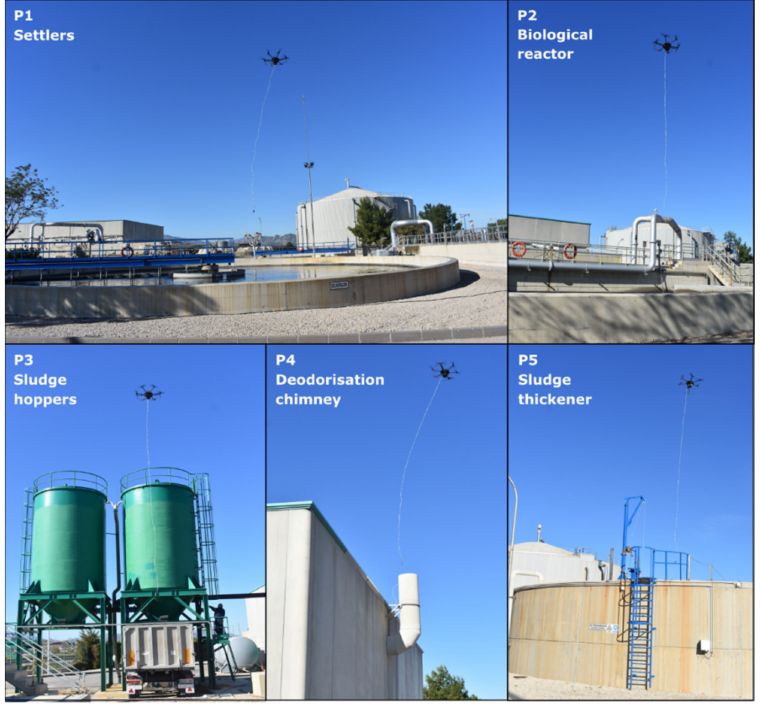
Figure 5. Drone hovering over the selected emission sources